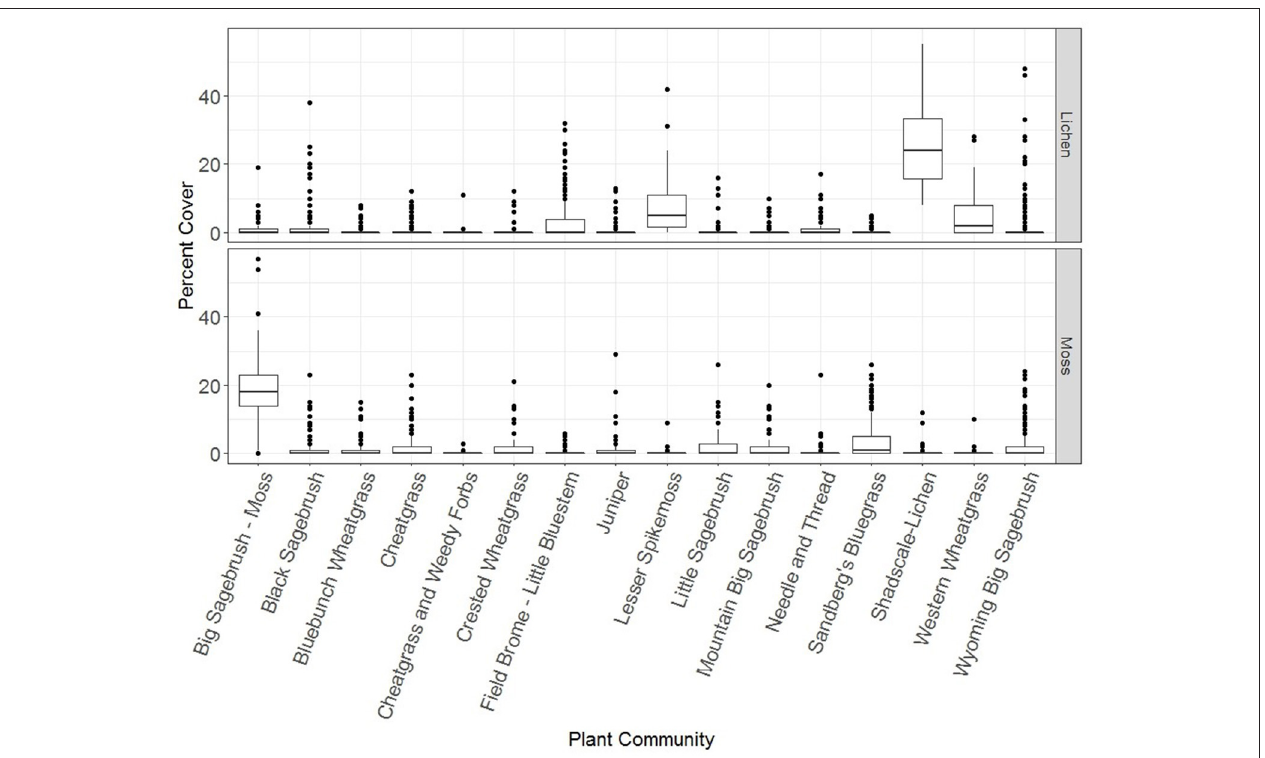
FIGURE 1 | Cover of lichens and mosses within each plant community across the western US summarized as boxplots. Boxplots show the inter quartile range. Whiskers show values within 1.5 the inter-quartile range, the distance between the first and third quantiles. Data beyond this range are plotted as individual points.